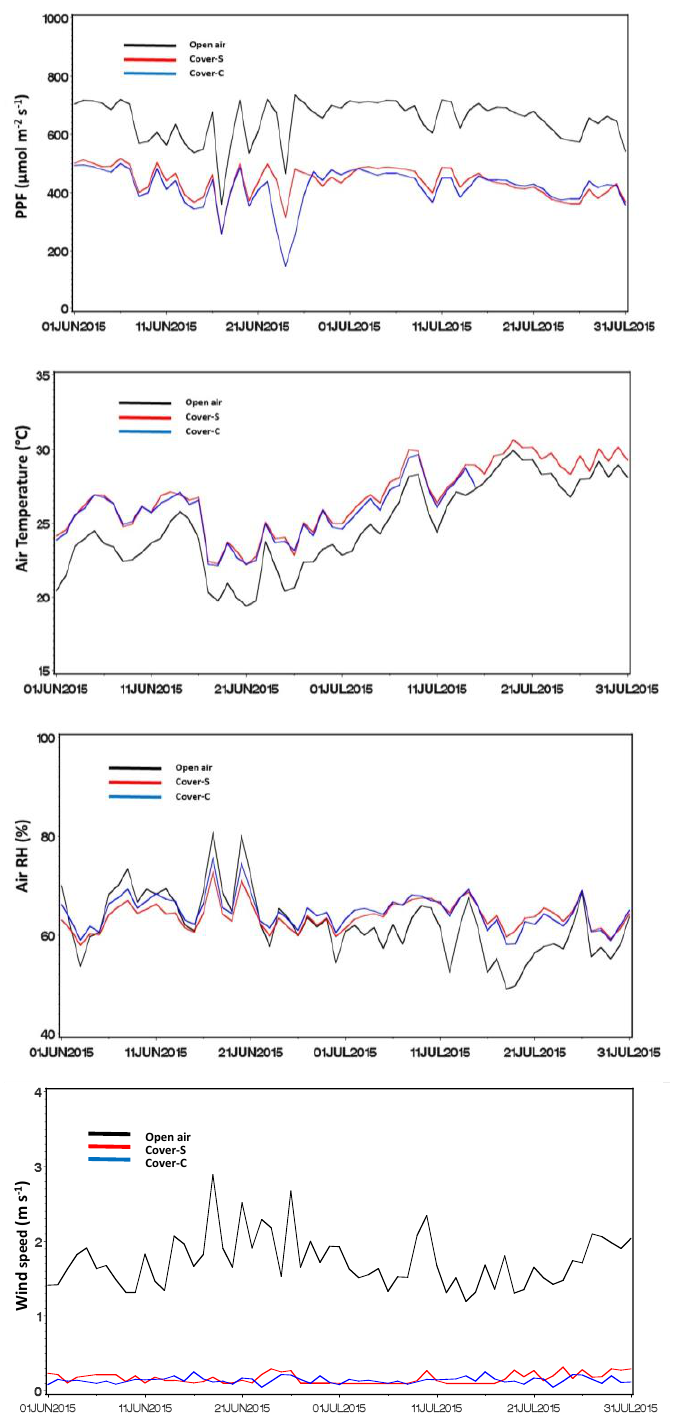
Figure 5. Course of average daily photosynthetic photon flux (PPF), air temperature, air relative humidity and wind speed recorded in June and July of the first year of trial, in open field and under plastic covers C (Coverlys ® agrotextile) and S (Serrosol